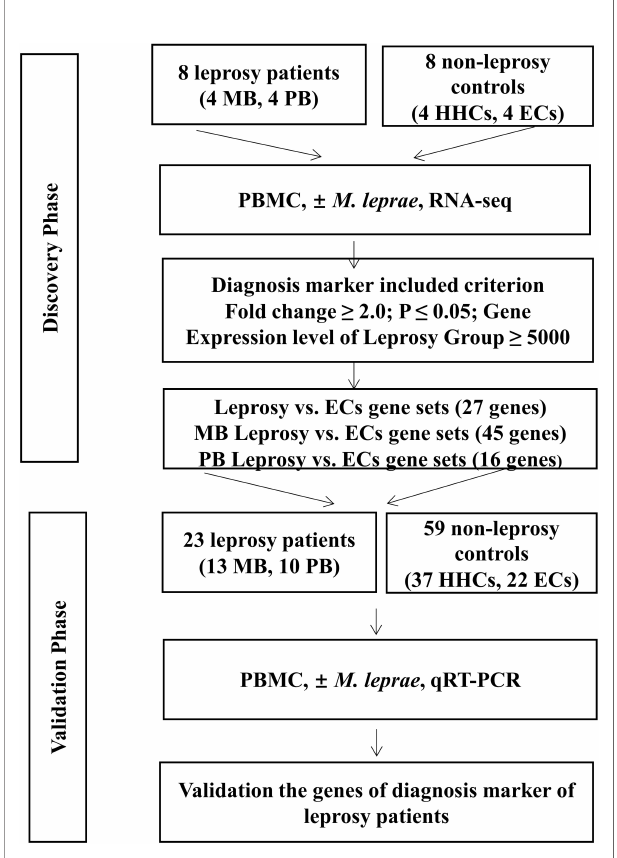
FIGURE 1 | Work fl ow of the study. The study was subdivided into the discovery and validation phases. In the discovery phase, we enrolled eight leprosy patients (four each of MB and PB) and eight non-leprosy controls (four each of HHCs and ECs). PBMCs of all subjects were subjected to M. leprae sonicate stimulation and the genes with a fold change (FC) ≥ 2(P < 0.05) in expression levels of the patient group ≥ 5,000 raw reads in RNA-seq analysis were identi fi ed. From this set of genes, we derived a set of genes as potential diagnostic biomarkers for MB and PB patients. In the validation phase, we enrolled 23 leprosy patients (13 MB and 10 PB) and 59 non-leprosy controls (37 HHCs and 22 ECs) and obtained RNA from M. leprae- stimulated PBMCs. We validated the genes as diagnostic biomarkers of leprosy using qRT-PCR. MB, multibacillary; PB, paucibacillary; HHCs, healthy house contacts; ECs, endemic controls; PBMC, peripheral blood mononuclear